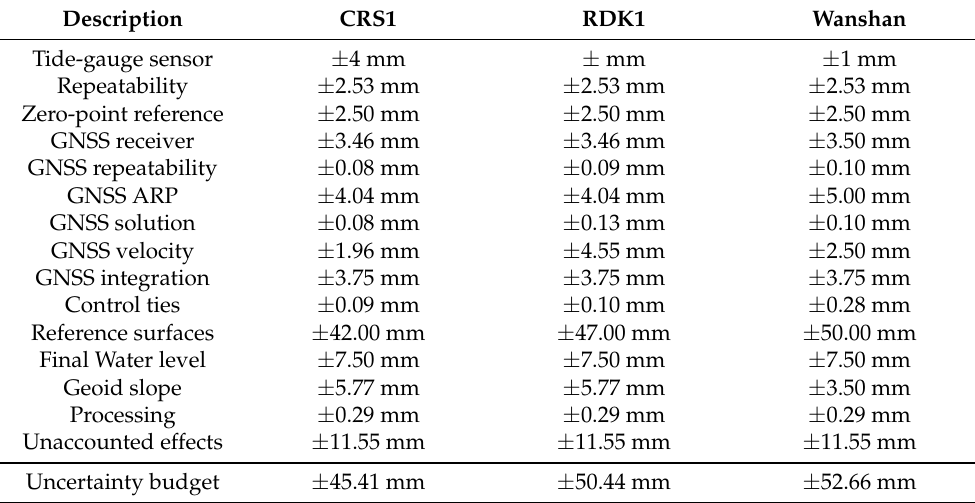
Table 4. Uncertainty Budget Analysis for Sea-surface